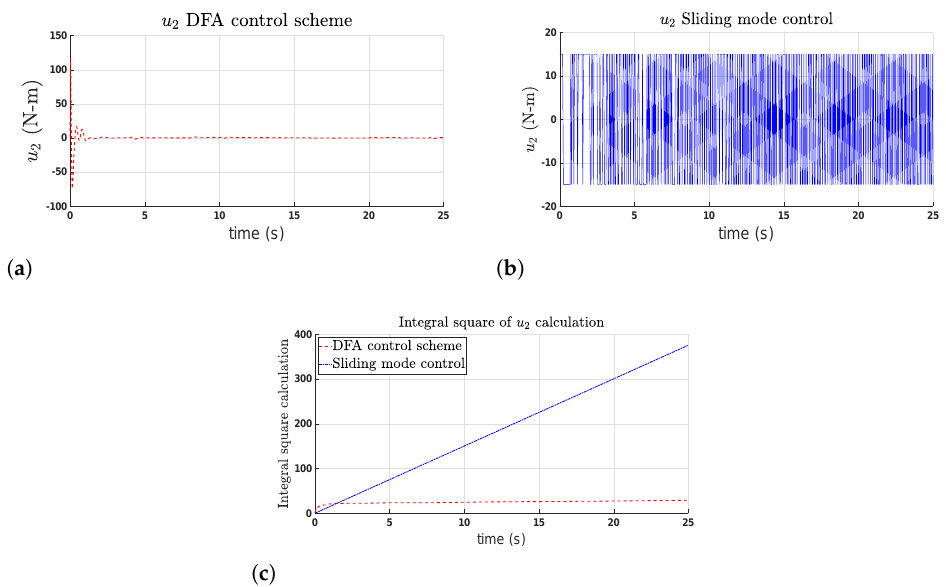
Figure 7. u 2 behavior results. ( a ) u 2 behavior (proposed control); ( b ) u 2 behavior (sliding mode control); ( c ) integral square of u 2 calculation.